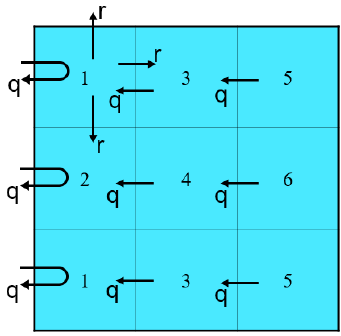
Figure 5. Inter-cell mobility model in a zone in 1ZR when a UE moves from the zone in the left ( n = 4).